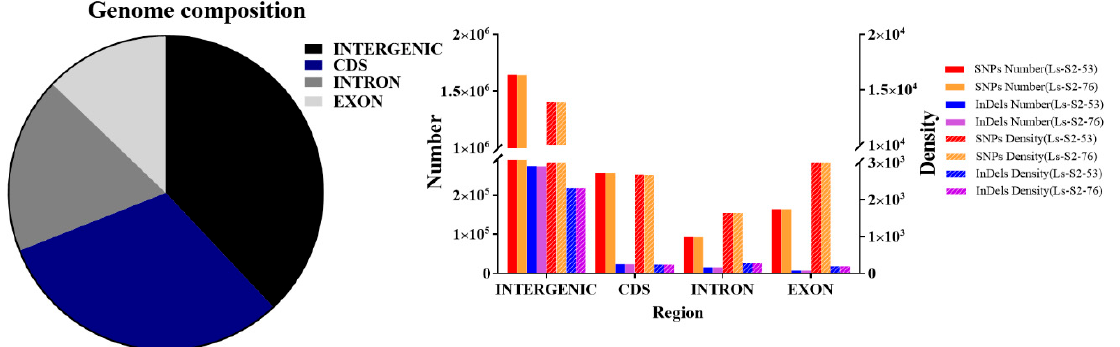
Figure 5. The chromosome composition and variation distribution of SNPs and indels in different regions of the F. viridis genome.